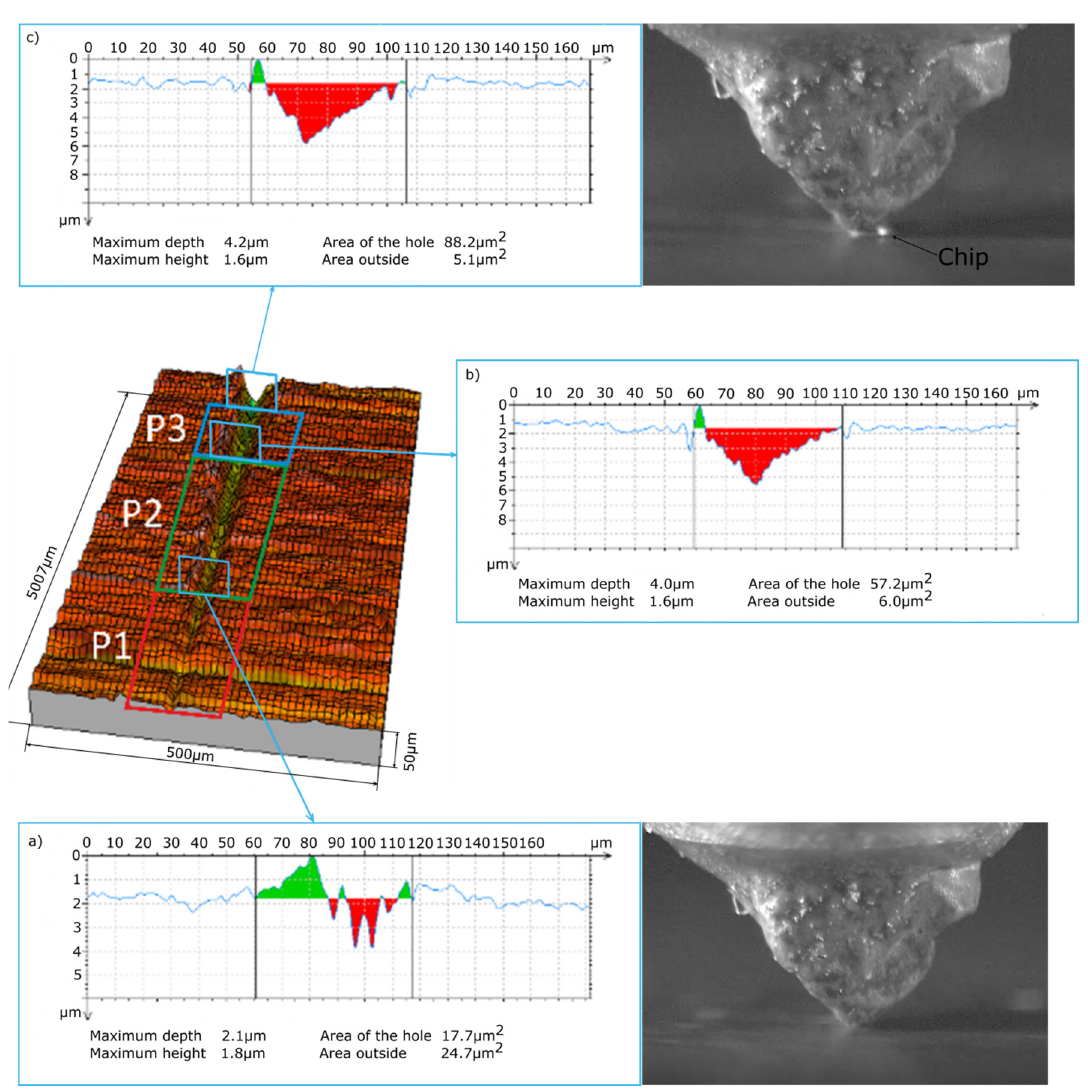
Figure 5. View of the initial stage of the scratch formed by the ZS1 abrasive grain and cross-sections of the scratch at the end of the stages: ( a ) P1, ( b ) P2 and ( c ) P3.